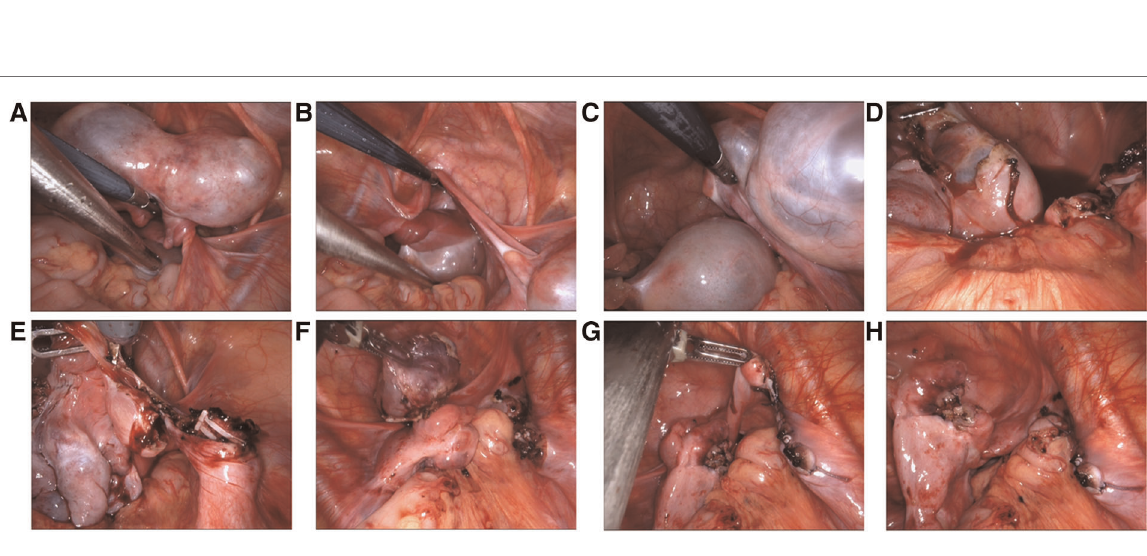
FIGURE 3 Surgical procedures of S-RALS for resection of ovarian tumors: ( A,B ) exposing the diseased ovaries fully. The images indicate bilateral ovarian torsion, ( C ) resetting the ovarian torsion, ( D ) opening the ovaries and exposing the tumor tissues, ( E,F ) removing the tumor along the tumor margin completely, and ( G,H ) suturing the ovarian tissues by 5-0 absorbable suture line. S-RALS, single-port robot-assisted laparoscopic